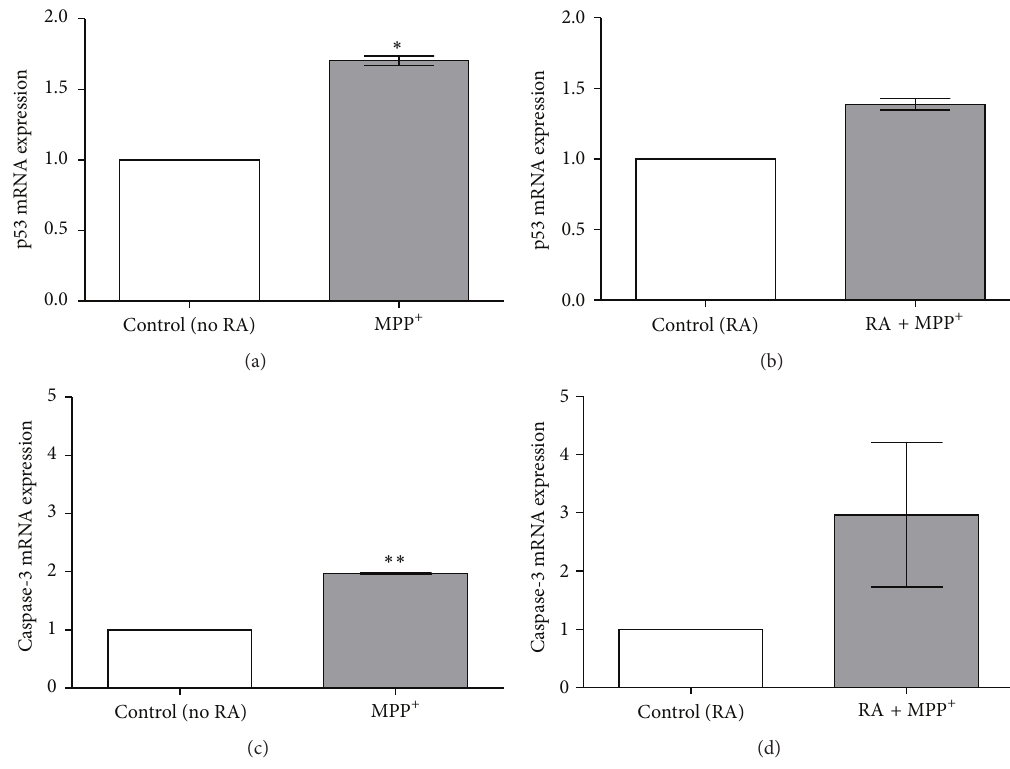
Figure 6: Effect of MPP + on p53 and caspase-3 mRNA expression in undifferentiated and differentiated SH-SY5Y cells. Cells were differentiated in 10- 𝜇 M retinoic acid (RA) for 3 days. Undifferentiated (a and c) and differentiated cells (b and d) were exposed to 500 and 1000 𝜇 M of MPP + for 24 hours, respectively. Expression of p53 mRNA (a and b) and caspase-3 (c and d) was analyzed with quantitative real-time RT-PCR, relatively compared to their respective untreated controls. The expression levels of the target gene were normalized to the expression level of 𝛽 -actin. Data are expressed as mean ± SEM ( 𝑛 = 3 ). ∗ 𝑃 < 0.05 ; ∗∗ 𝑃 < 0.01